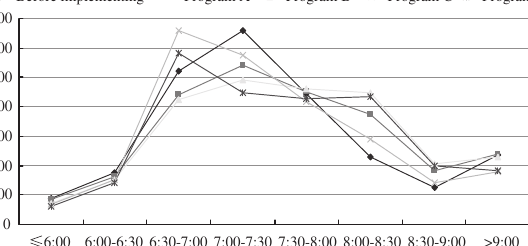
Fig. 3. Evaluation results of the integrated